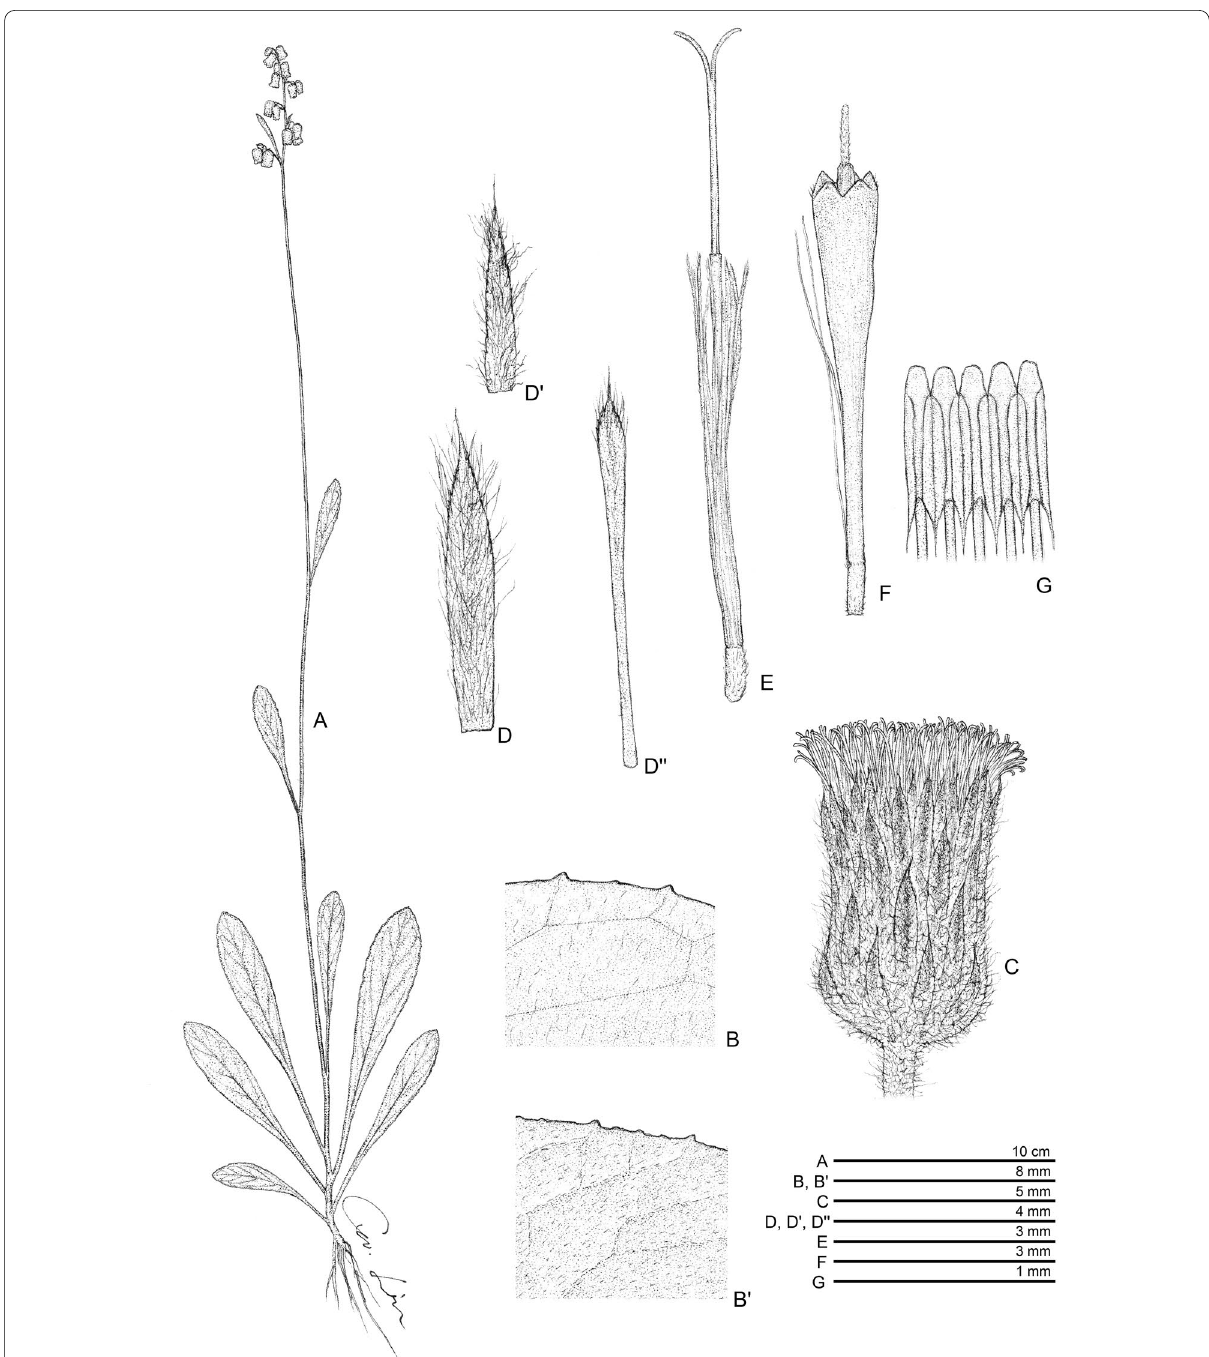
Fig. 2 Blumea chishangensis . A habit; B basal leaves, upper surface; B’ basal leaves, lower surface; C head; D , D" involucral bracts: E outer floret; F central floret; G